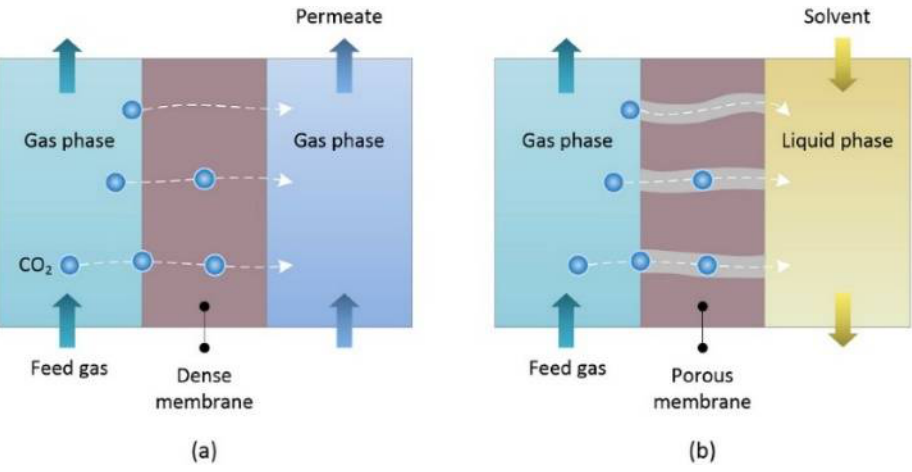
Figure 4. Schematic of ( a ) membrane gas separation (MGS) and ( b ) membrane contactor (MC) for CO 2 removal. Reproduced with permission from [65], Elsevier, 2019.